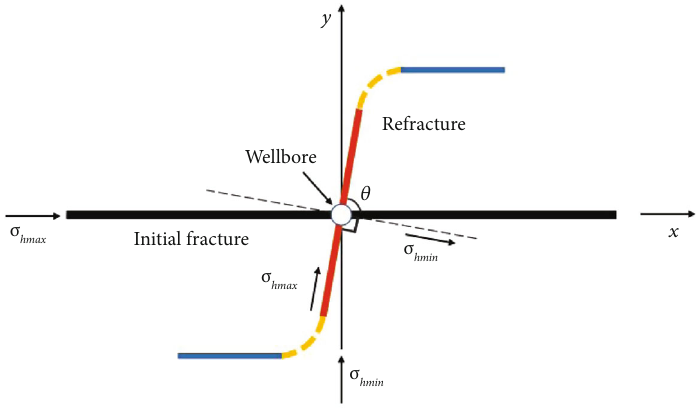
Figure 1: Schematic of the refractured